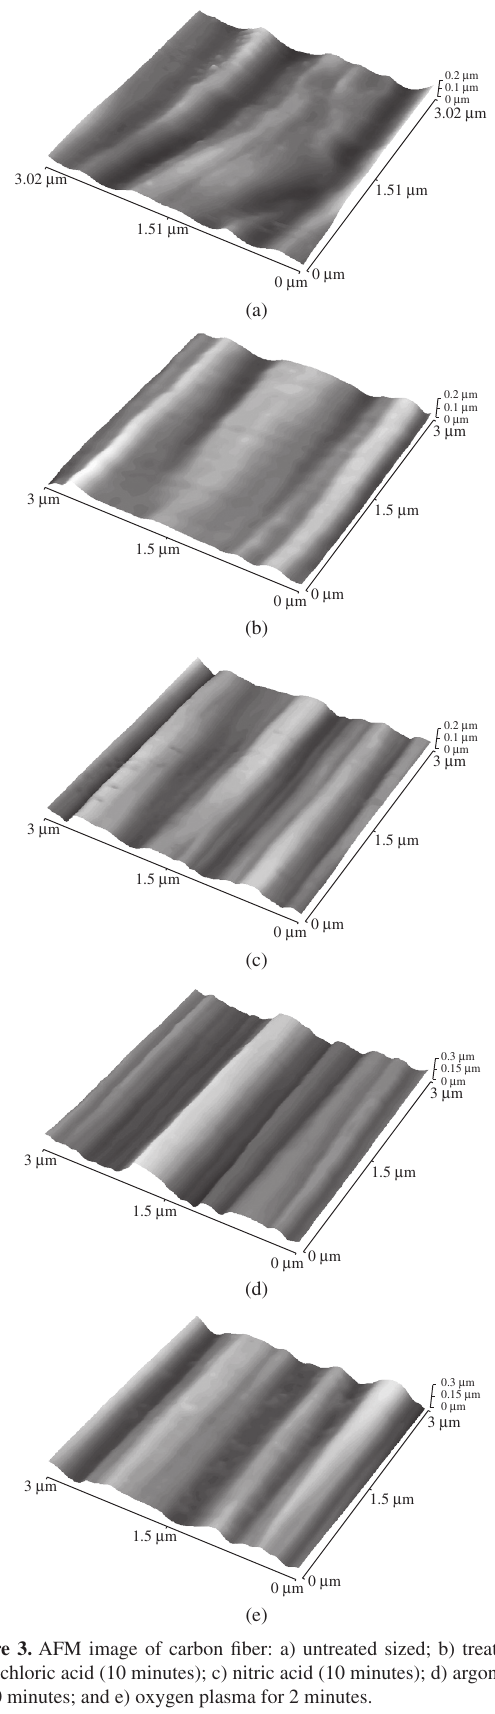
Figure 3. AFM image of carbon fiber: a) untreated sized; b) treated with hydrochloric acid (10 minutes); c) nitric acid (10 minutes); d) argon plasma for 10 minutes; and e) oxygen plasma for 2